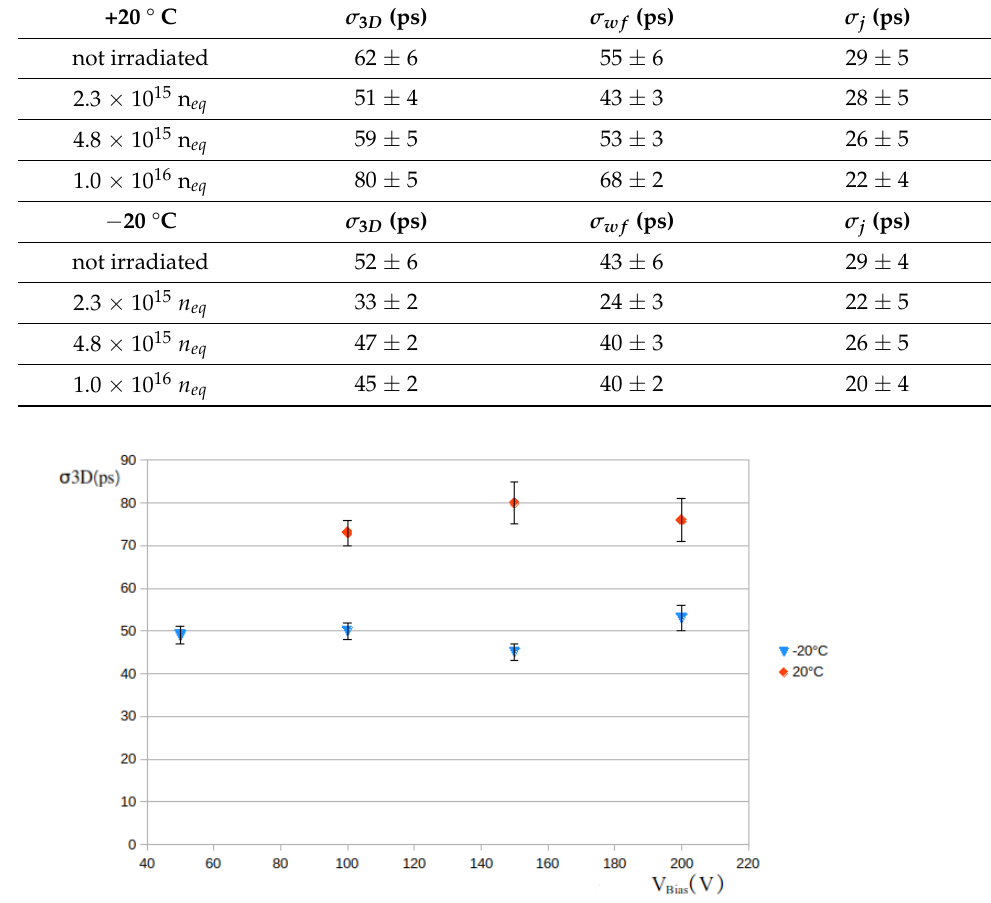
Figure 9. Time resolution σ 3 D vs. bias voltage at 20 and − 20 °C for 1.0 × 10 16 n eq